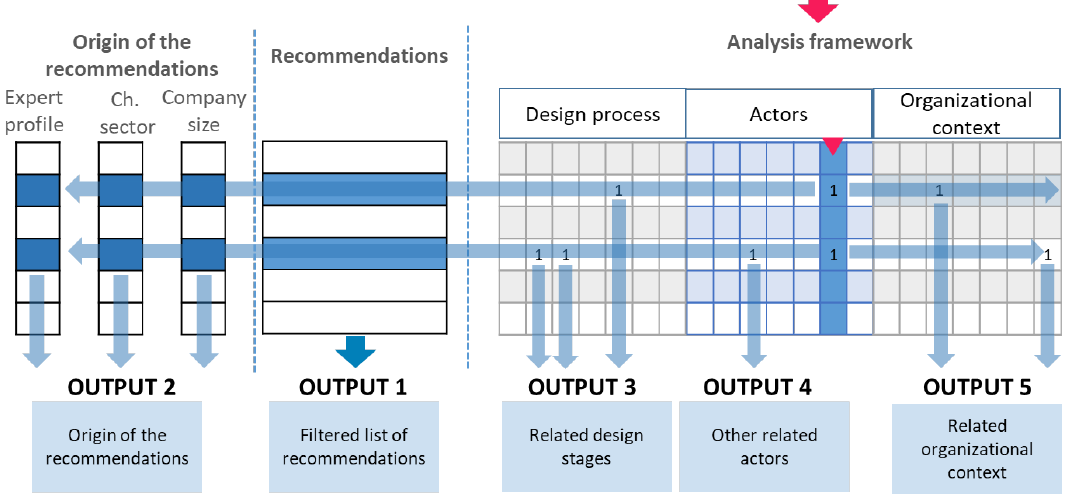
Figure 11. Example 1: Filtering the knowledge base to see the recommendations related to the actor